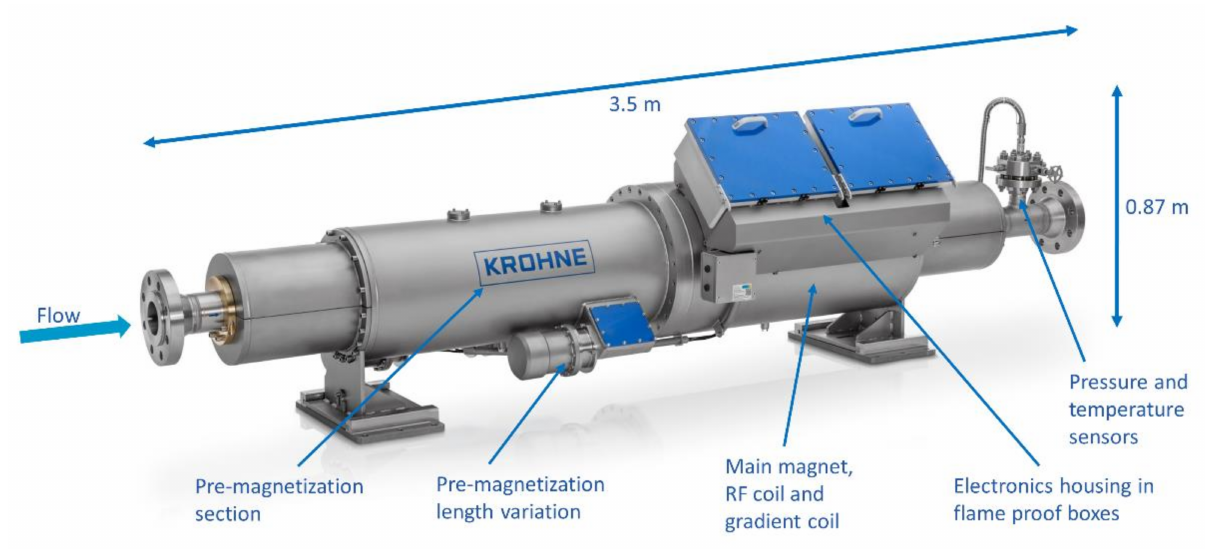
Figure 8. Annotated photograph of the KROHNE MPHASE 5000 MR-based multiphase flow meter used for the flow experiments presented in this work. Image courtesy of KROHNE